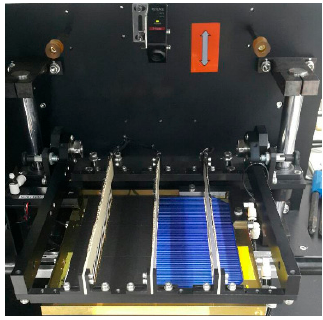
Figure 5. Actual IV measurement of a c-Si solar cell.